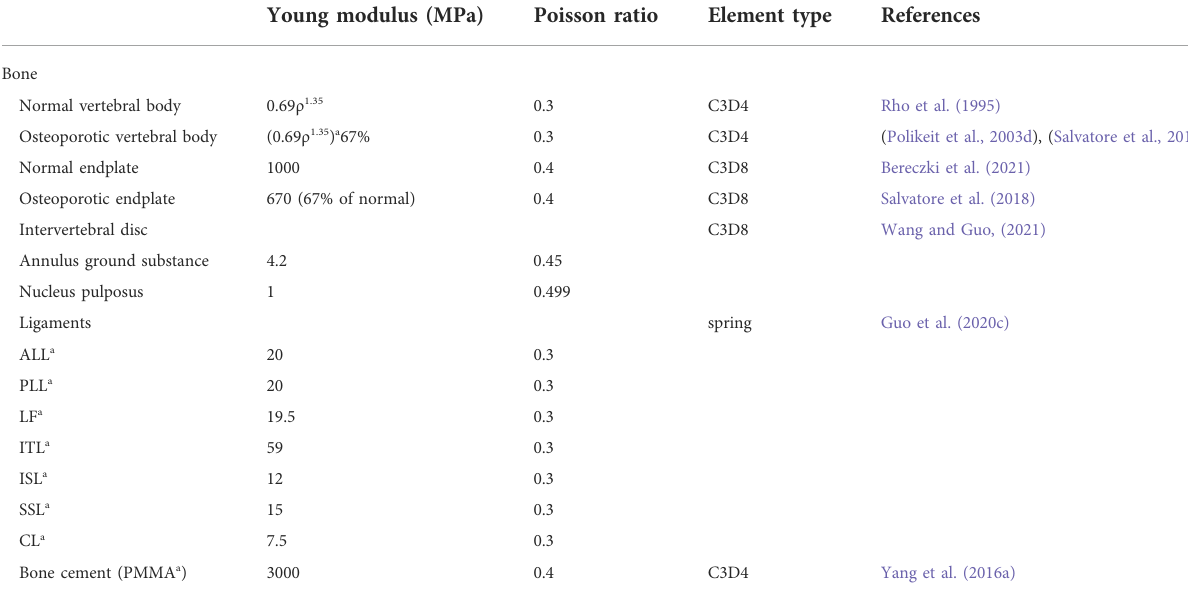
TABLE 2 Material properties of fi nite element analysis